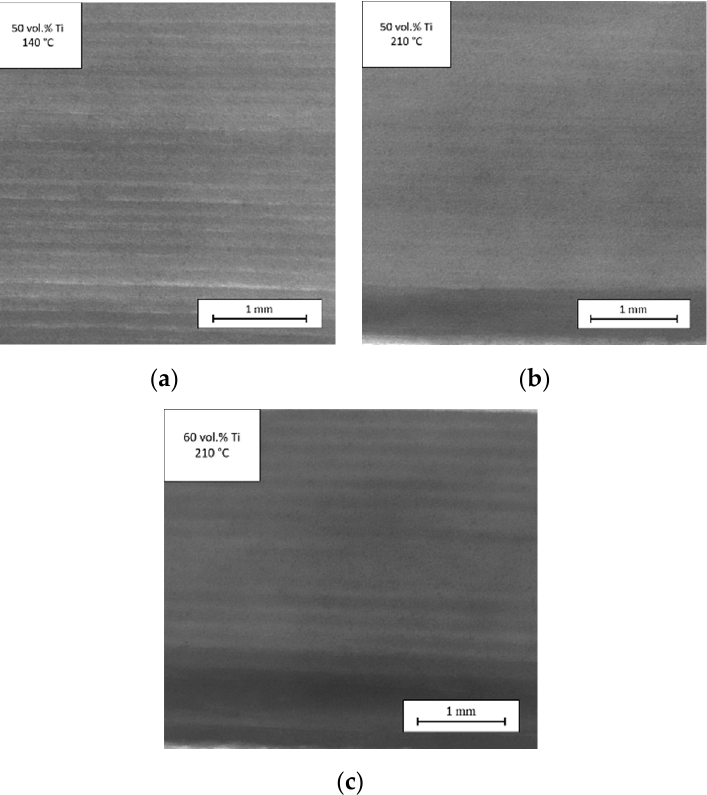
Figure 15. Influence of temperature and titanium concentration on welding of deposited layers: ( a ) 50 vol.% Ti particles and processing temperature of 140 °C; ( b ) 50 vol.% Ti particles and processing temperature of 210 °C; ( c ) 60 vol.% Ti particles and processing temperature of 210 °C.